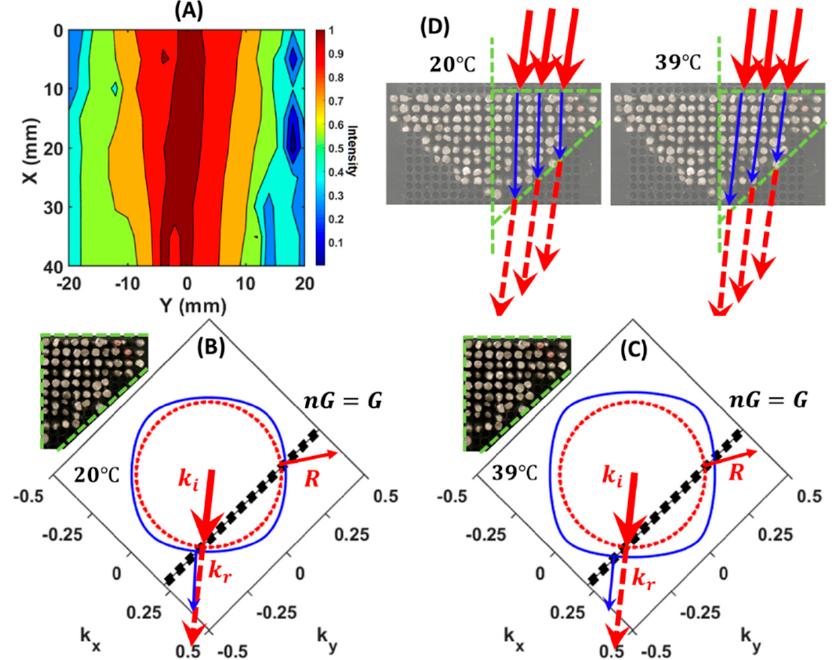
Figure A1. ( A ) Sound intensity field of the source planar transducer. The value of 0 mm on the Y -axis refers to the surface of the transducer. ( B ) Equi-frequency contour (EFC) of TSSL at 20 ◦ C. ( C ) EFC of TSSL at 39 ◦ C. ( D ) Illustration of the focusing mechanism based on the refracted wave vectors from ( B , C ) The unit of k x , k y and G was 2 π /a. The red arrows referred the wave direction in water. The blue arrows referred the wave direction in lens.